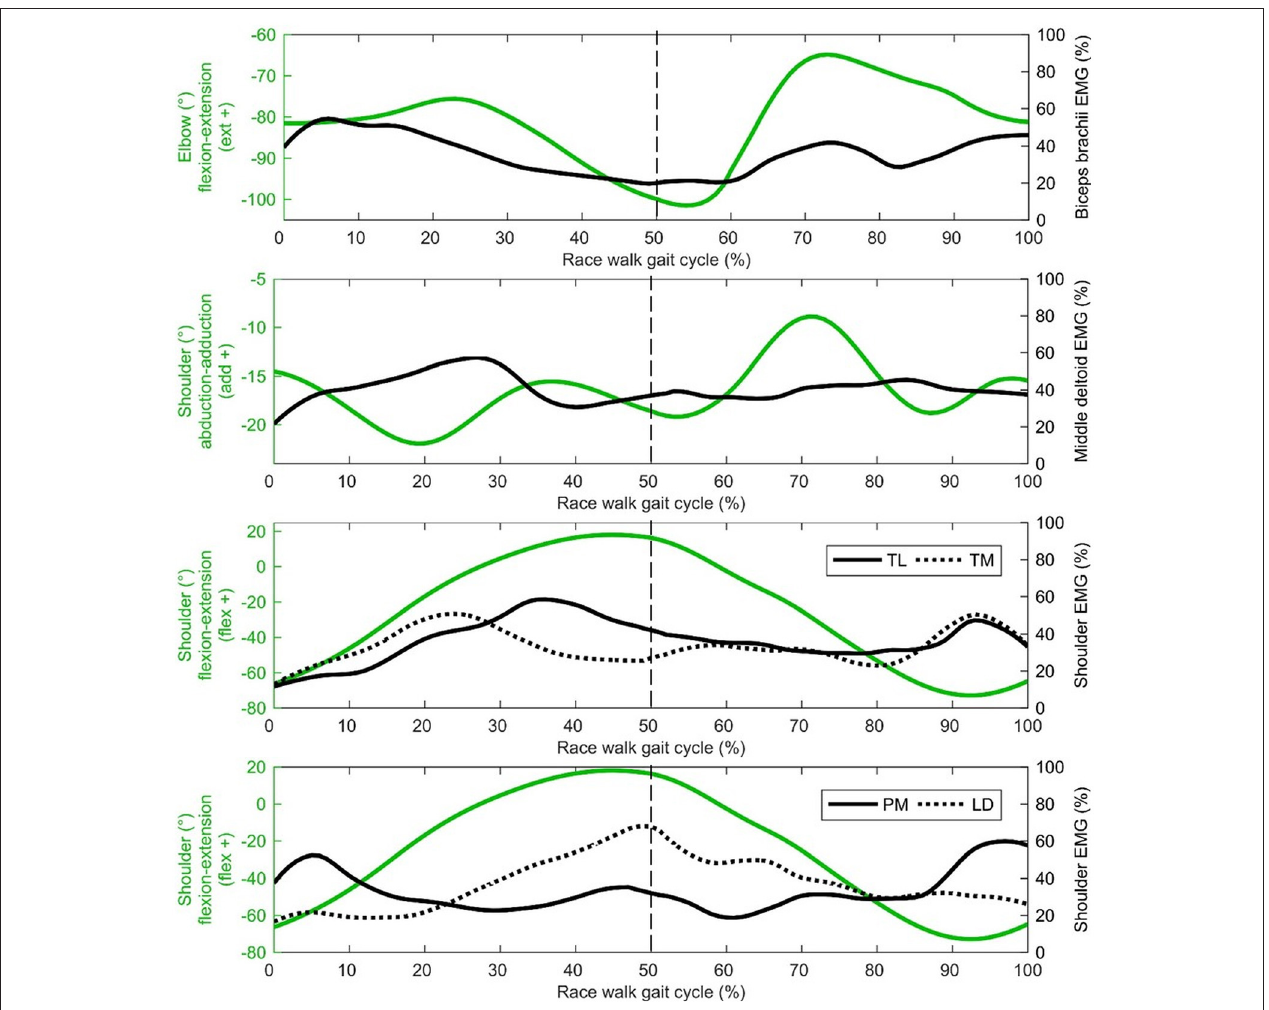
FIGURE 4 | Shoulder and elbow group mean joint angle kinematics (green) presented with EMG activity (black) on the secondary axis [biceps brachii, middle deltoid, trapezius lower (TL), trapezius middle (TM dotted), pectoralis major (PM), latissimus dorsi (LM dotted)]. The dashed vertical line represents gait cycle division between stance (from 0 to 50%) and swing (from 50 to